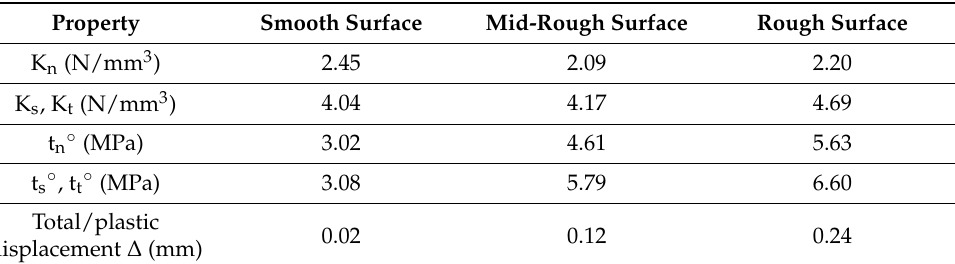
Table 2. Mechanical parameters of the surface-based cohesive model for different types of NSC- UHPFRC interfaces.